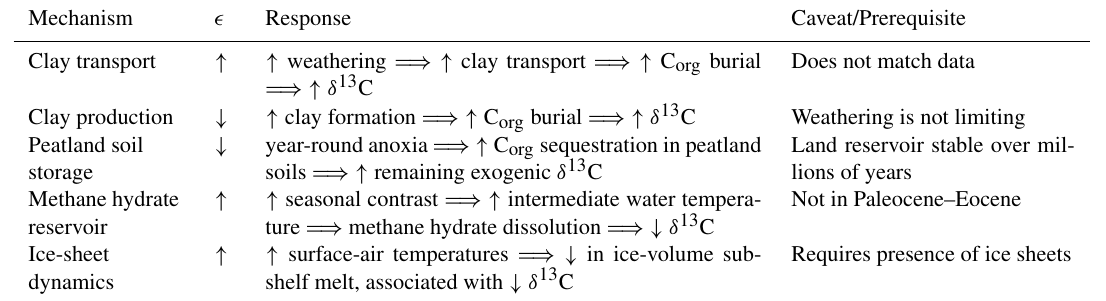
Figure 1. Long-term high-resolution benthic foraminiferal stable carbon and oxygen isotope records show 405kyr cyclicity. (a) Palaeo- ceanographic reconstruction of 30Ma with approximate site locations. Map generated with GPlates, using the rotation frame and tectonic re- construction of (Matthews et al., 2016). Data from references in the legend show the 405kyr periodicity in the δ 18 O (b) and δ 13 C (c) records throughout the Cenozoic at various sites in the Pacific. Darker lines going through the records represent 20-point moving averages while darker lines at arbitrary heights represent the 405kyr filtered records (at 2 . 47 ± 0 . 15Myr − 1 ). The Westerhold et al. (2011) record was con- verted to the GTS2012 (Ogg, 2012) timescale by converting magnetic chron ages and placing the Paleocene–Eocene Thermal Maximum (PETM) onset at 56.0Ma. Note the ∼ 16Myr x -axis break in the Eocene. Table 1. Possible mechanisms that can cause δ 13 C– δ 18 O to co-occur as a result of input eccentricity (cid:15) forcing maxima ( ↑ ) and minima ( ↓ ).